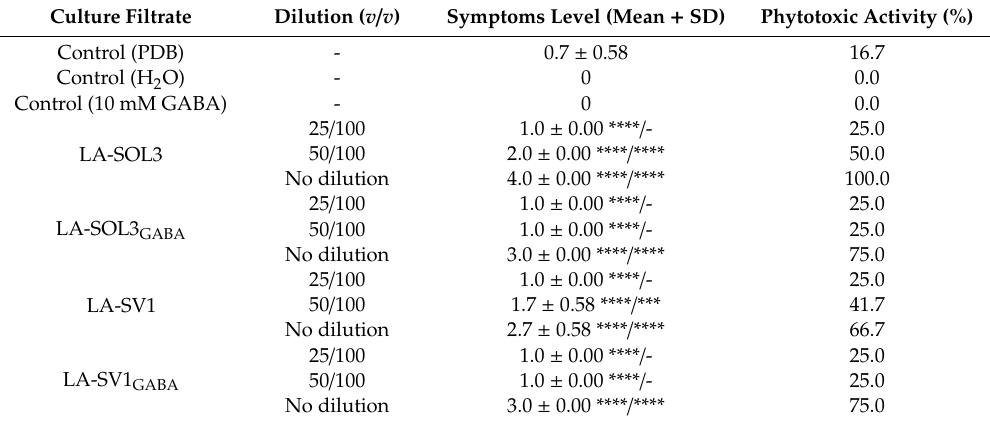
Table 1. Phytotoxicity (%) of culture filtrates of LA-SOL3 and LA-SV1 grown in the presence and absence of 10 mM of γ -aminobutyric acid (GABA). Statistical analysis was performed using two-way ANOVA followed by a Tukey multiple comparison test (Water / PDB). Asterisks correspond to data with statistical di ff erence (**** p < 0.0001, *** p < 0.001) to PDB or H 2 O.